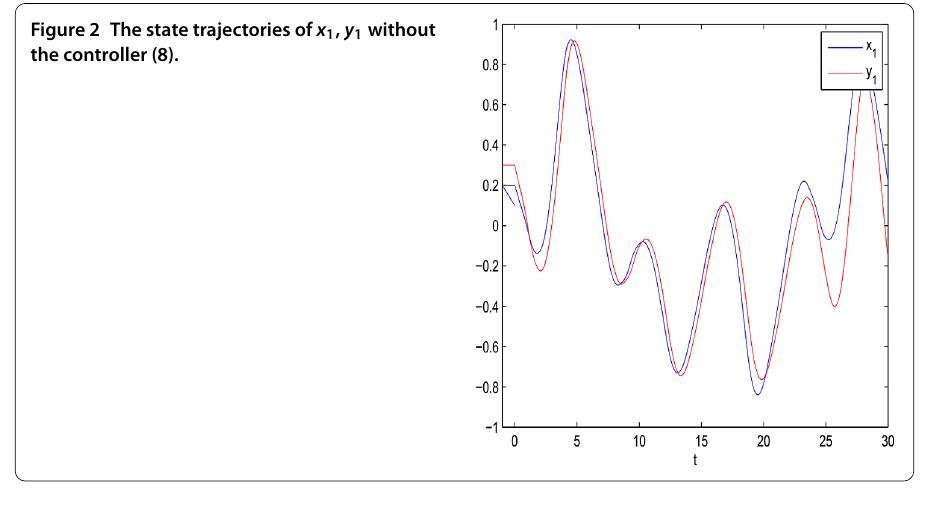
Figure 2 The state trajectories of x 1 , y 1 without the controller (8).